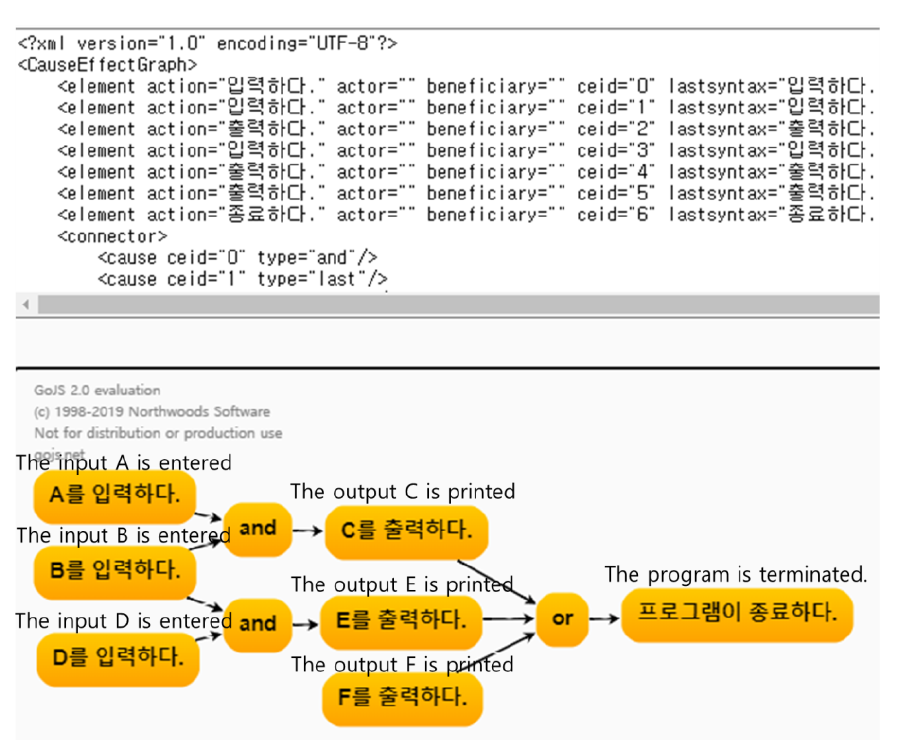
Figure 14. The automatic C3Tree model generation.